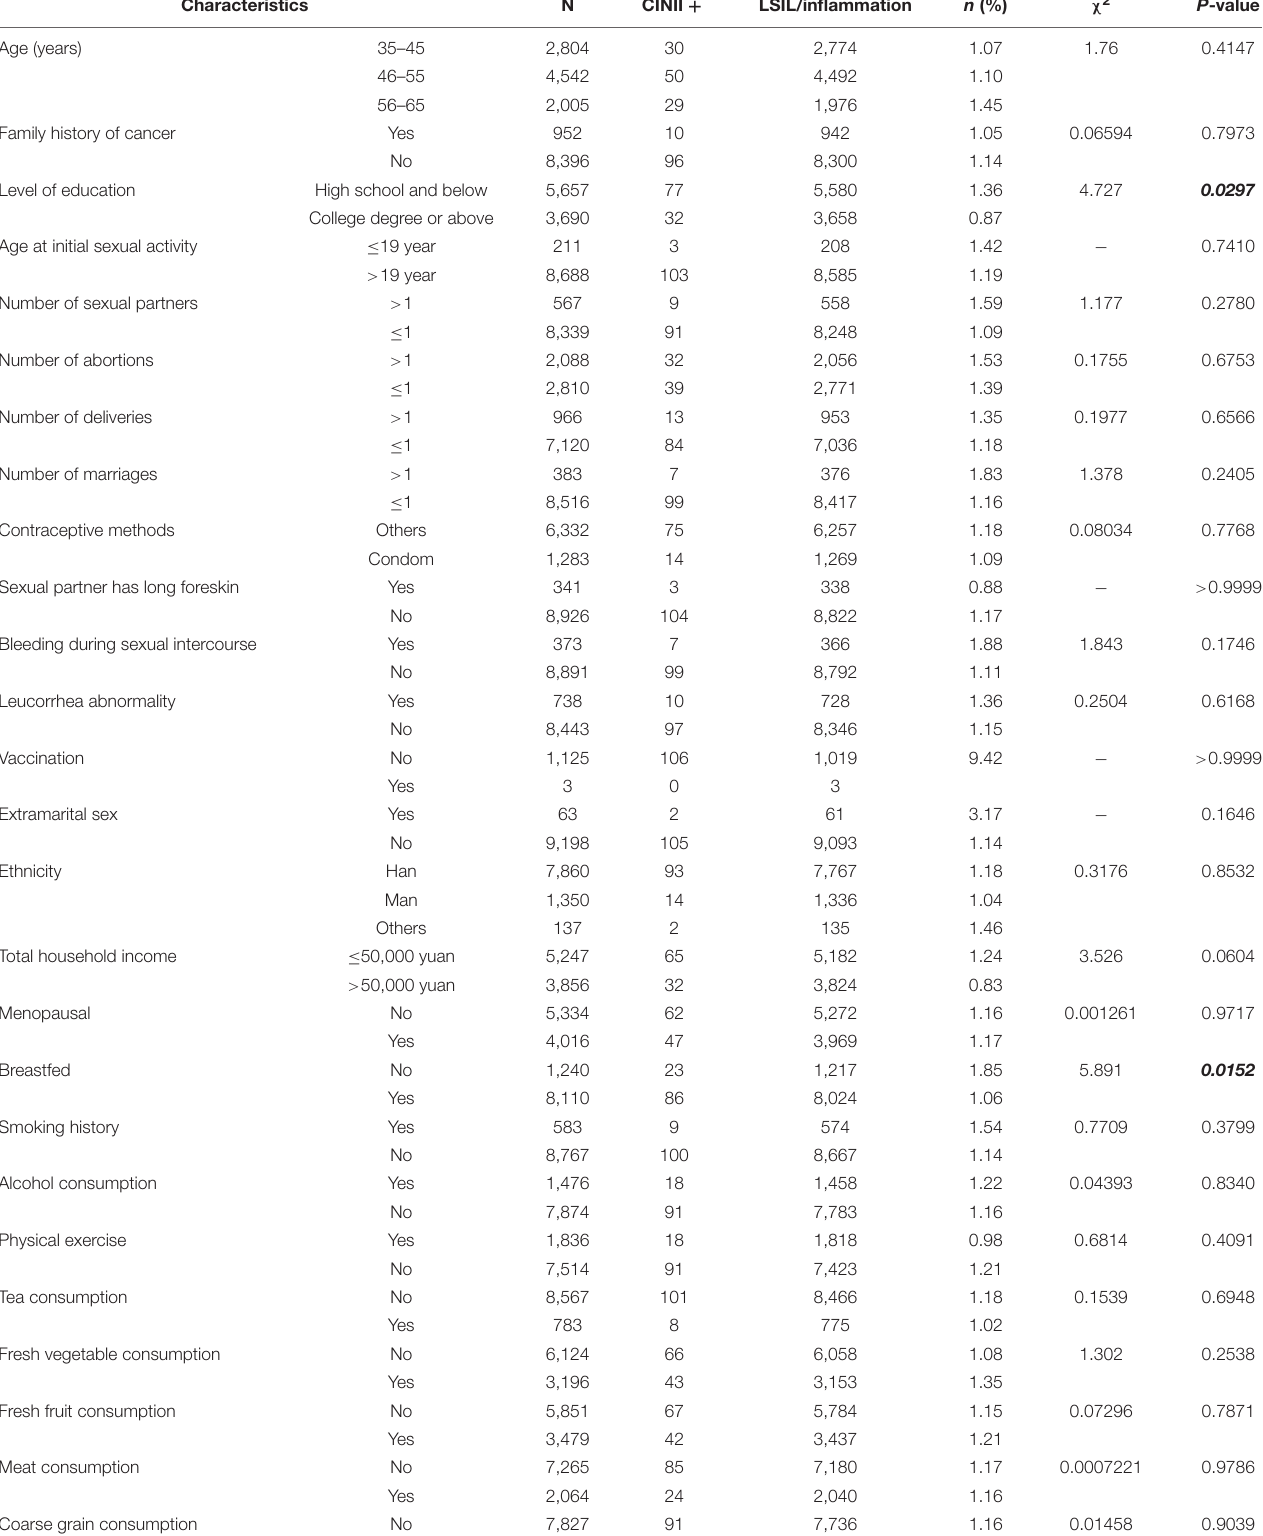
TABLE 12 | Comparison of detection rates of high-grade squamous intraepithelial lesion positive (CINII + ) in populations with different basic characteristics.